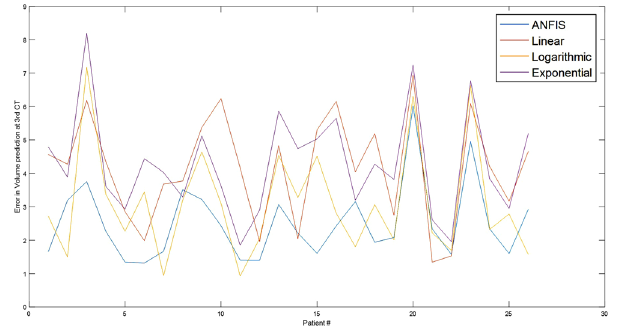
Figure 1. Comparison of mean squared of prediction error showing less errors by ANFIS compared to other prediction